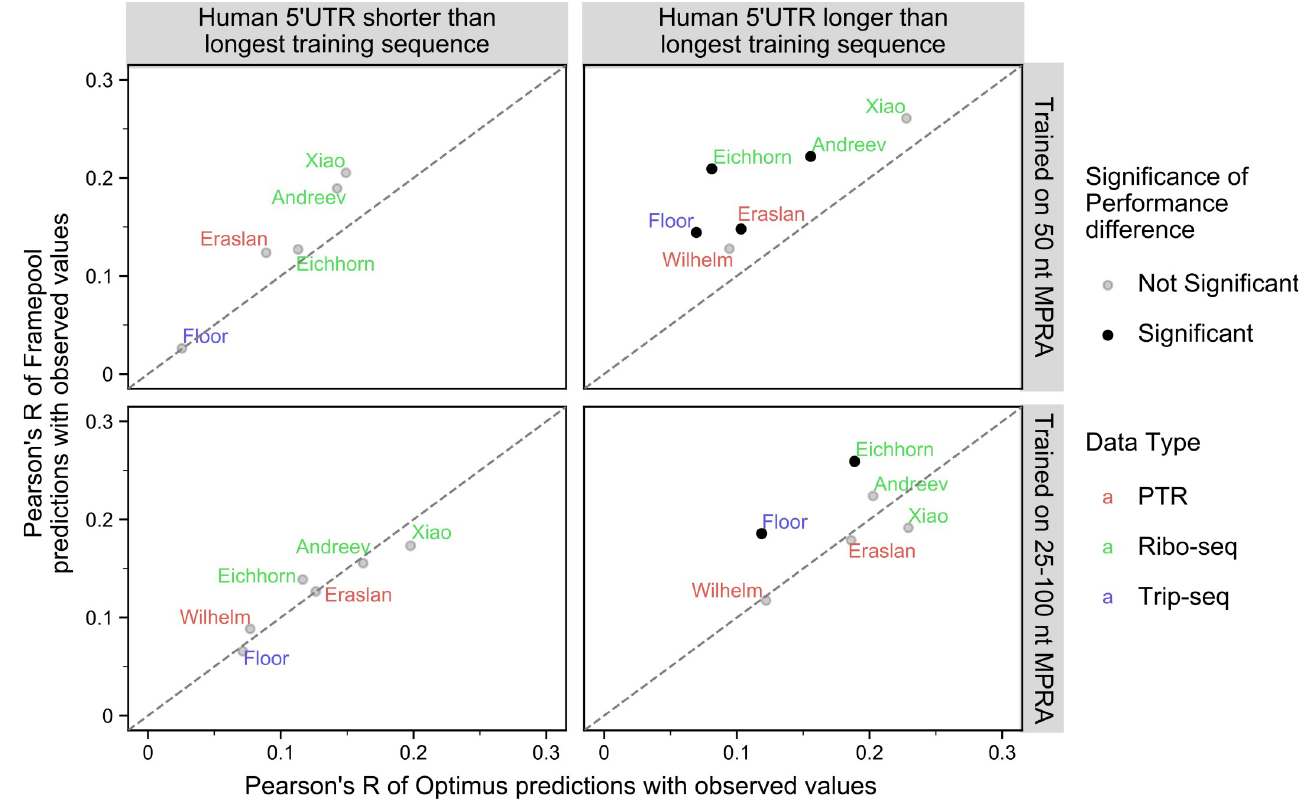
Fig 4. Correlating Optimus and Framepool MRL predictions with a variety of translation-efficiency related measurements for human transcripts. Pearson’s correlation between MRL predictions and various published translation-efficiency related measurements for Framepool (y-axis) against Optimus (x- axis) for human 5’UTR sequences shorter than the longest training sequence (left column) or larger (right column) and when the model is trained on 50 nt MPRA (top row) or the variable-length MPRA (bottom row). Dataset labels are colour-coded by measurement type: Protein-to-mRNA ratio (red), Ribo-Seq (green), and TripSeq (blue). For 5’UTR sequences shorter than 50 nt, no significant difference can be observed between FramePool50 and Optimus50 (the diagonal line indicates identical performance). For those longer than 50 nt, FramePool50 significantly outperforms Optimus on 4 out of 6 datasets. FramePool100 and Optimus100 show indistinguishable performance on 5’UTR sequences shorter than 100 nucleotides. For sequences longer than 100 nt, FramePool100 significantly outperforms Optimus on 2 out of 6 datasets, with inconclusive results for the other sets. This suggests that frame pooling captures additional signals from longer sequences in endogenous data. Significance is assessed by bootstrapping and corrected for multiple testing (Bonferroni, Methods).